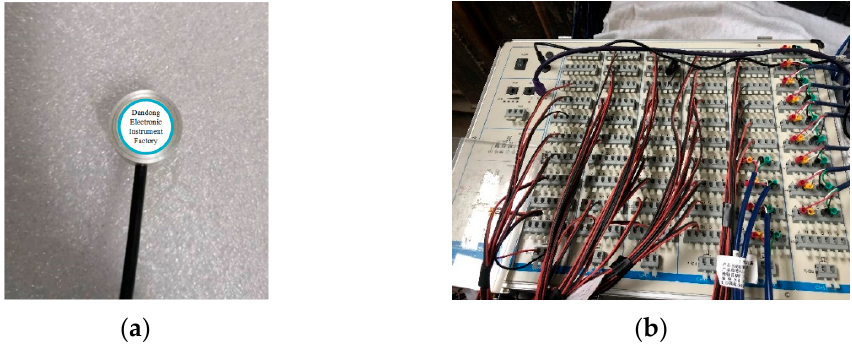
Figure 13. Soil pressure test instrument. ( a ) Soil pressure box, ( b ) Multi-function strain